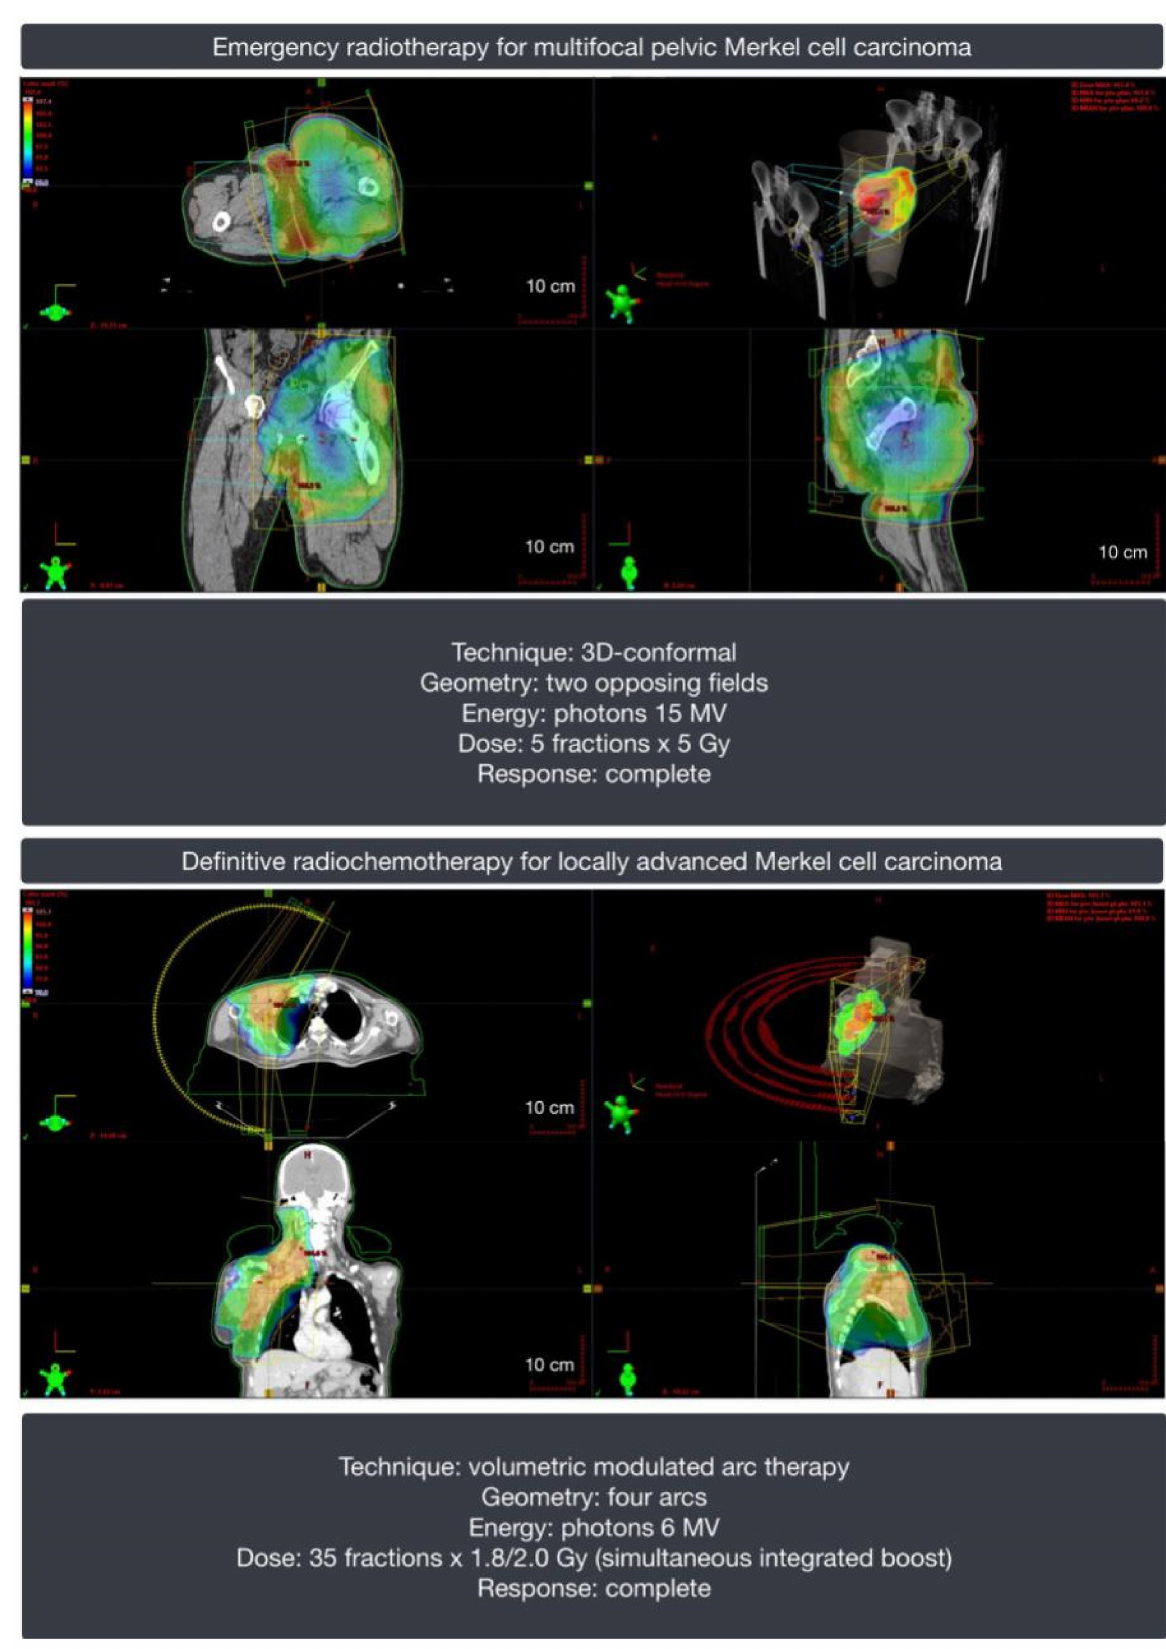
Figure 8. Radiotherapy plans for Merkell cell